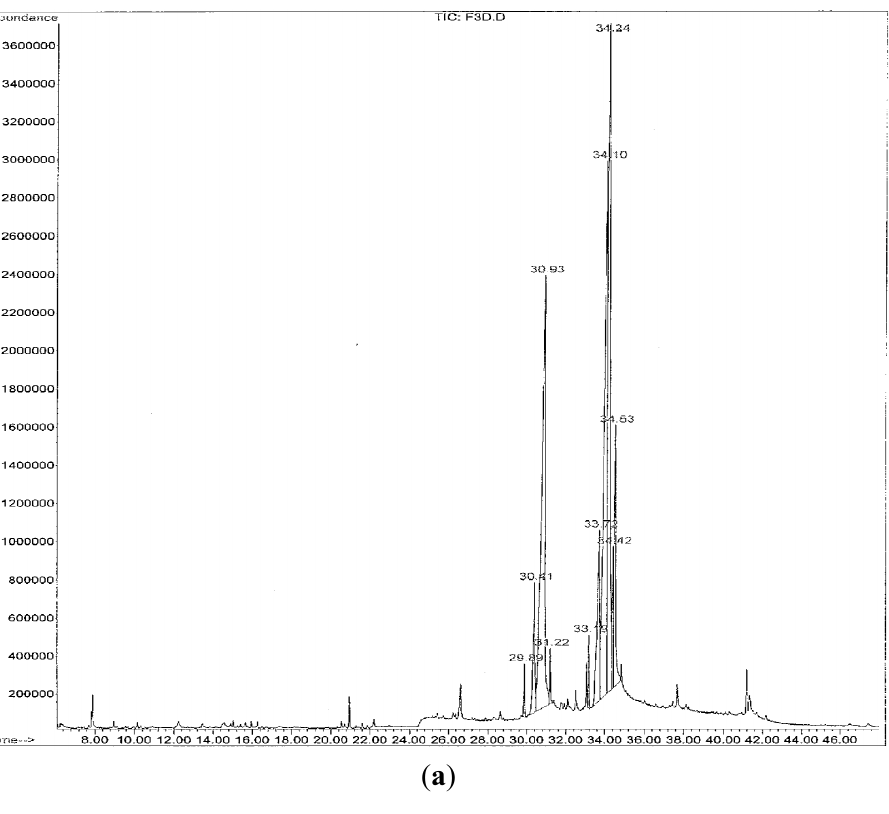
Figure 2. ( a ) GC-MS chromatogram of F3; ( b ) GC/MS chromatogram of F11; ( c ) GC-MS chromatogram of